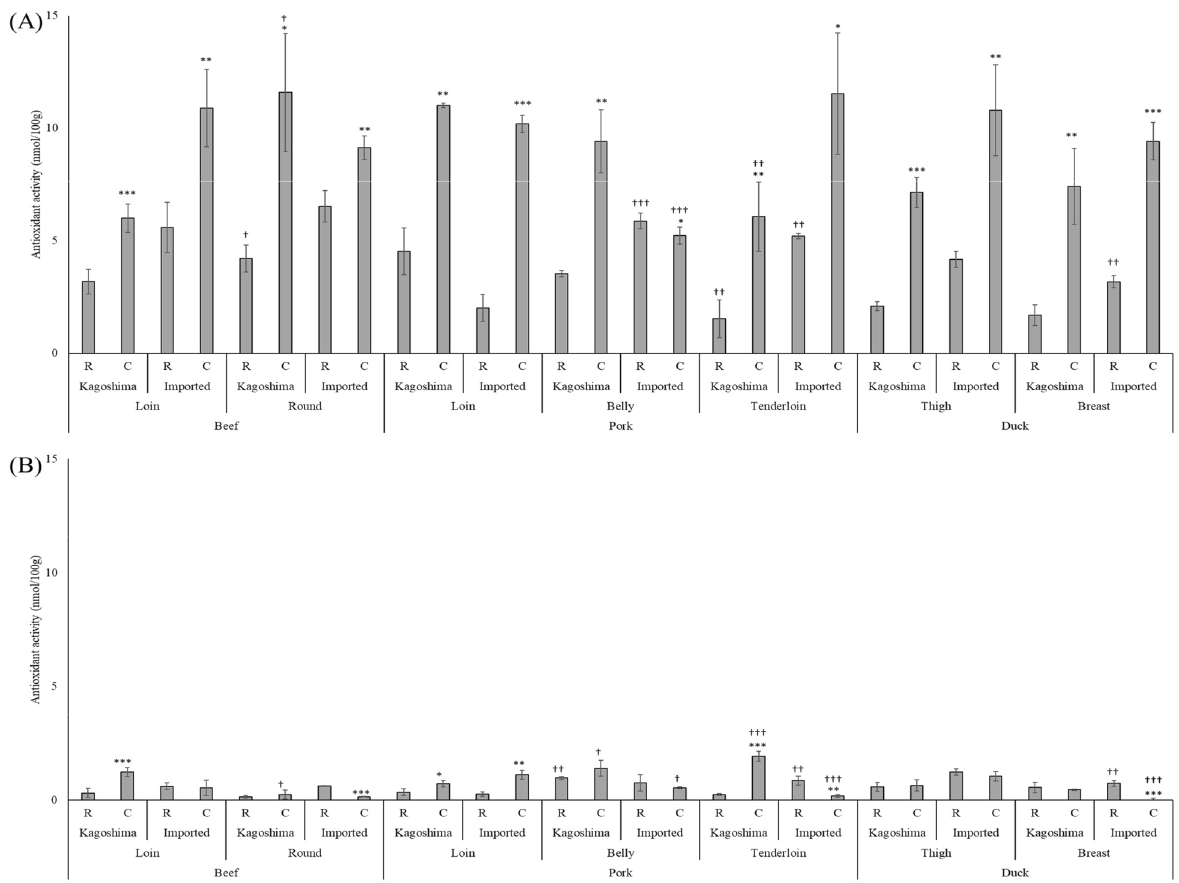
Figure 3. Antioxidant activities of ( A ) hydrophilic and ( B ) lipophilic meat-sample extracts. R raw, C cooked. Asterisk indicates P < 0.05 vs . raw. Double asterisk indicates P < 0.01 vs. raw. Triple asterisk indicates P < 0.001 vs. raw. Dagger indicates P < 0.05 vs. loin (beef and pork) or thigh (duck). Double dagger indicates P < 0.01 vs. loin (beef and pork) or thigh (duck). Triple dagger indicates P < 0.001 vs. loin (beef and pork) or thigh (duck).